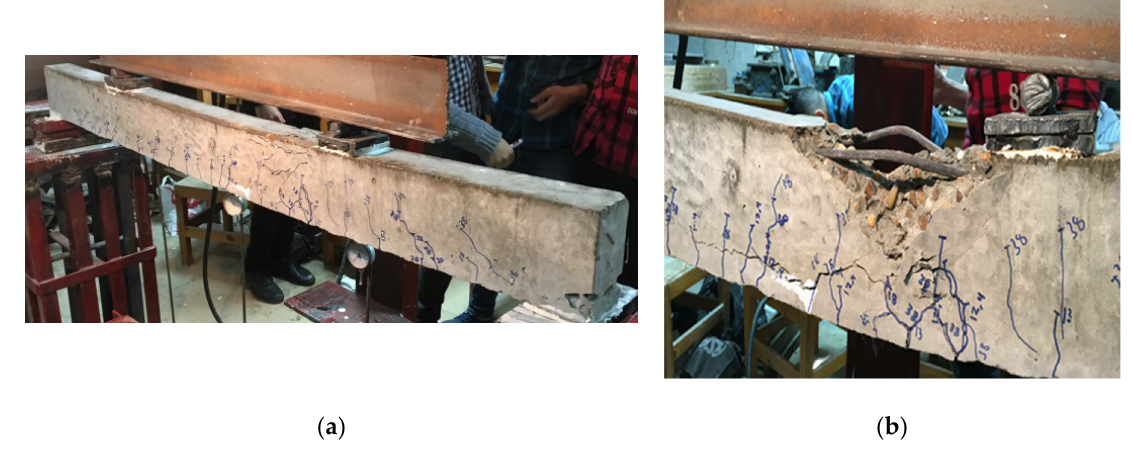
Figure 7. Crack pattern of the control beam B0: ( a ) crack pattern ( b ) buckling of the top bars. The crack pattern of beam B0 * is depicted in Figure 8. The same cracks and failure manner as in the case of B0 were observed for this beam. The middle third’s use of the stirrups widened the cracks where 31 cracks were present in this beam. Additionally, the top bar’s buckling was less severe than that of B0’s. Figure 8b displays a picture of the B0 * after the test was completed.